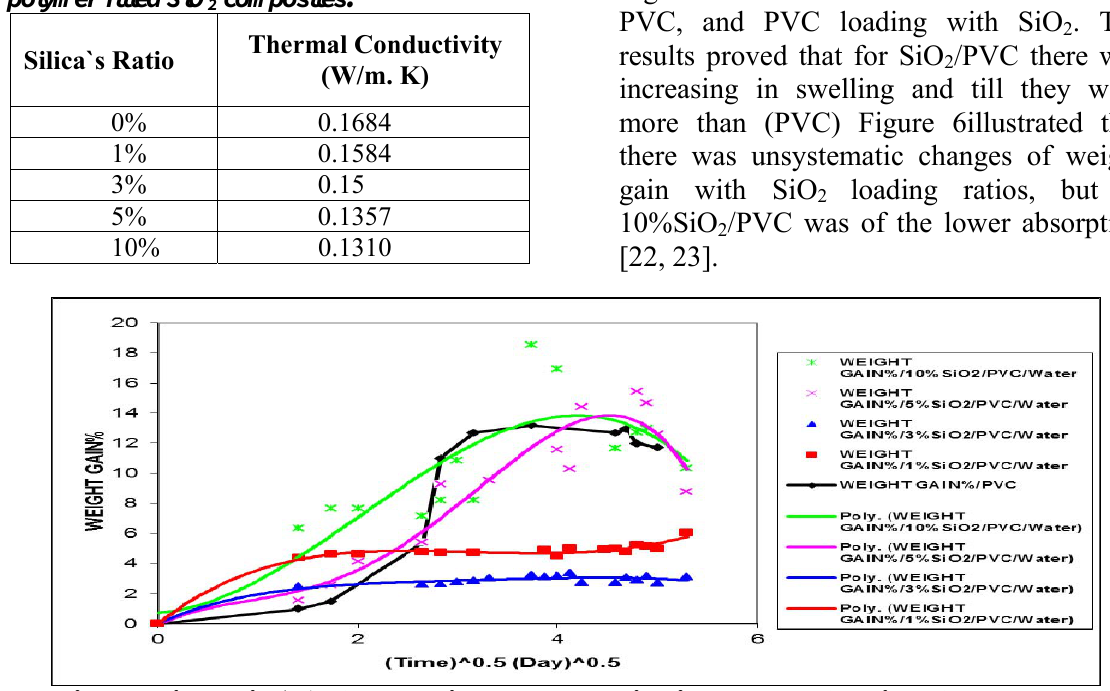
/PVC composites in water as a function of square root of 2 immersion